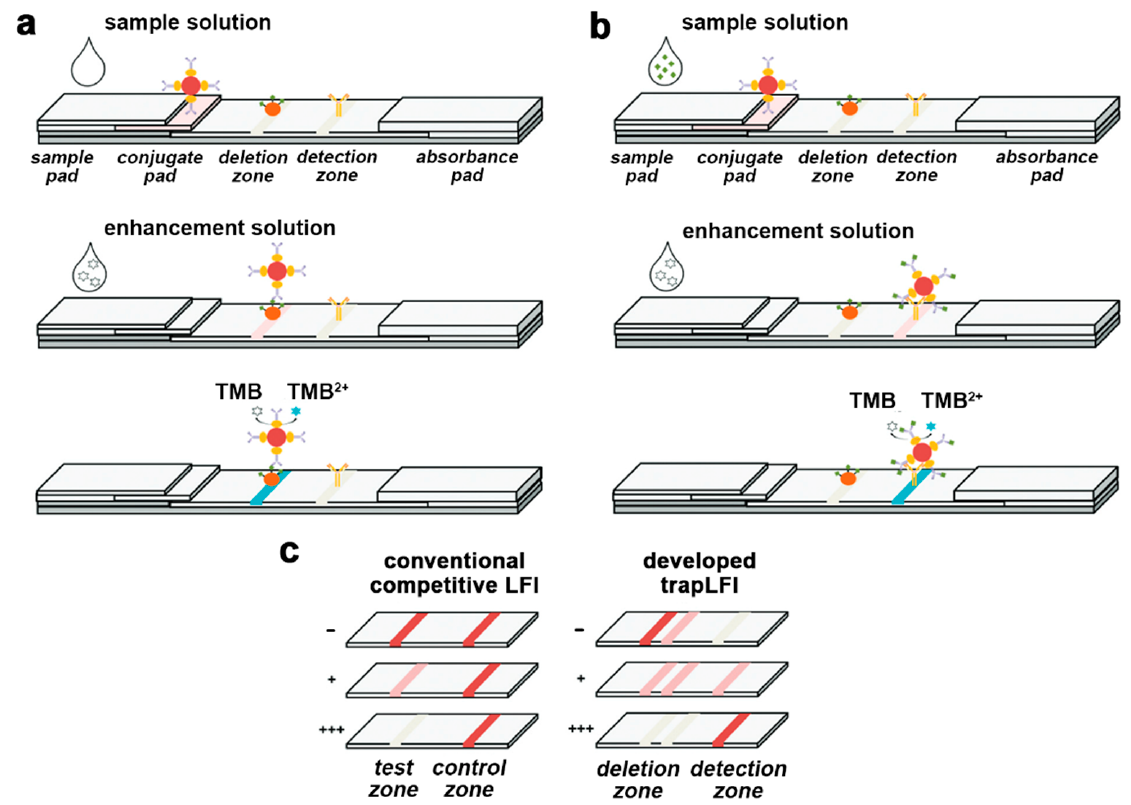
Figure 1. Schematic illustration of mechanism for the trapLFI biosensor with ( a ) low and ( b ) high concentration of cortisol, and ( c ) comparison of signal behavior of conventional competitive LFIA and trapLFI biosensor in the presence of different concentrations of cortisol (- negative sample, + positive sample low concentration, +++ positive sample high concentration). Adapted from Ref. [52], Copyright (2018), with permission from The Royal Society of